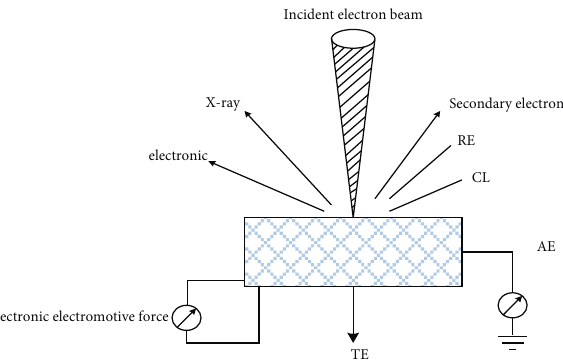
Figure 7: Schematic diagram of incident electron beam bombarding the sample. Table 2: The main parameters of ultrasonic cleaning machine.